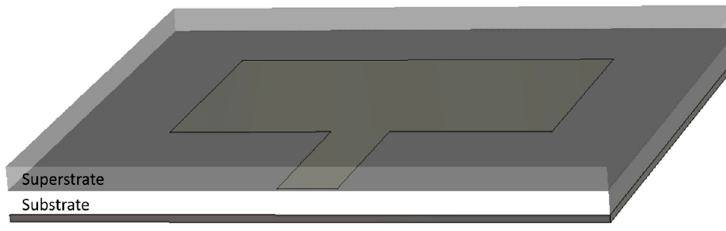
Figure 2. Di ff erent types of antenna sensors. Figure 2. Different types of antenna sensors.